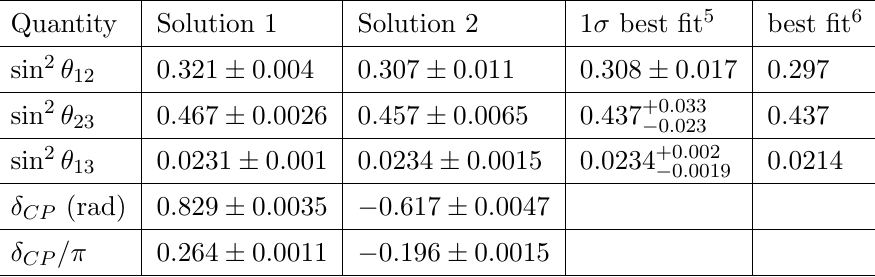
Table 1 . The values of the PMNS parameters for the two solutions of Case II.